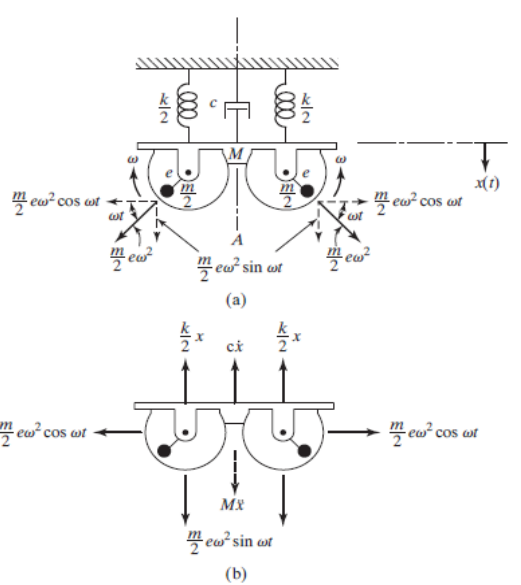
Fig. 2. Rotating unbalanced